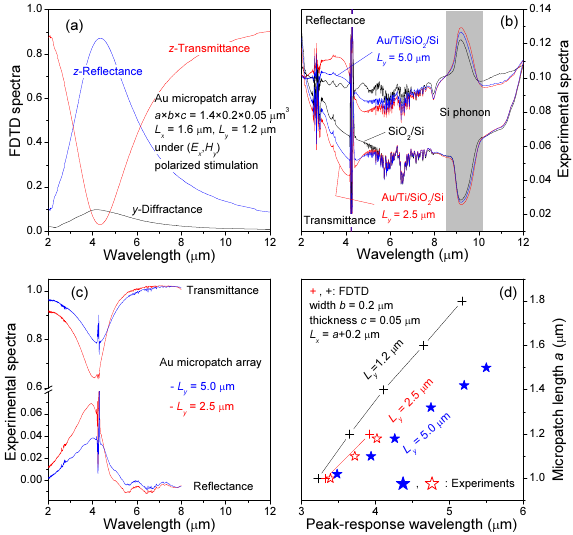
Figure 2. FDTD and FTIR studies. ( a ) FDTD transmittance, reflectance, and diffractance of one Au micropatch array 1.4 × 0.2 × 0.05 µ m 3 under ( E x , H y ) polarized stimulation. ( b ) FTIR transmittance and reflectance spectra of SiO 2 /Si and two Au/Ti/SiO 2 /Si samples. Blue: 1.18 × 0.24 × 0.05 µ m 3 , L x = 1.2 µ m, L y = 5.0 µ m; Red: 1.18 × 0.24 × 0.05 µ m 3 , L x = 1.1 µ m, L y = 2.5 µ m. The upper three spectra are reflectance, while the lower three are transmittance spectra. ( c ) Extracted transmittance and reflectance spectra of the Au/Ti micropatch arrays. ( d ) Peak-response wavelength as a function of the Au micropatch length a